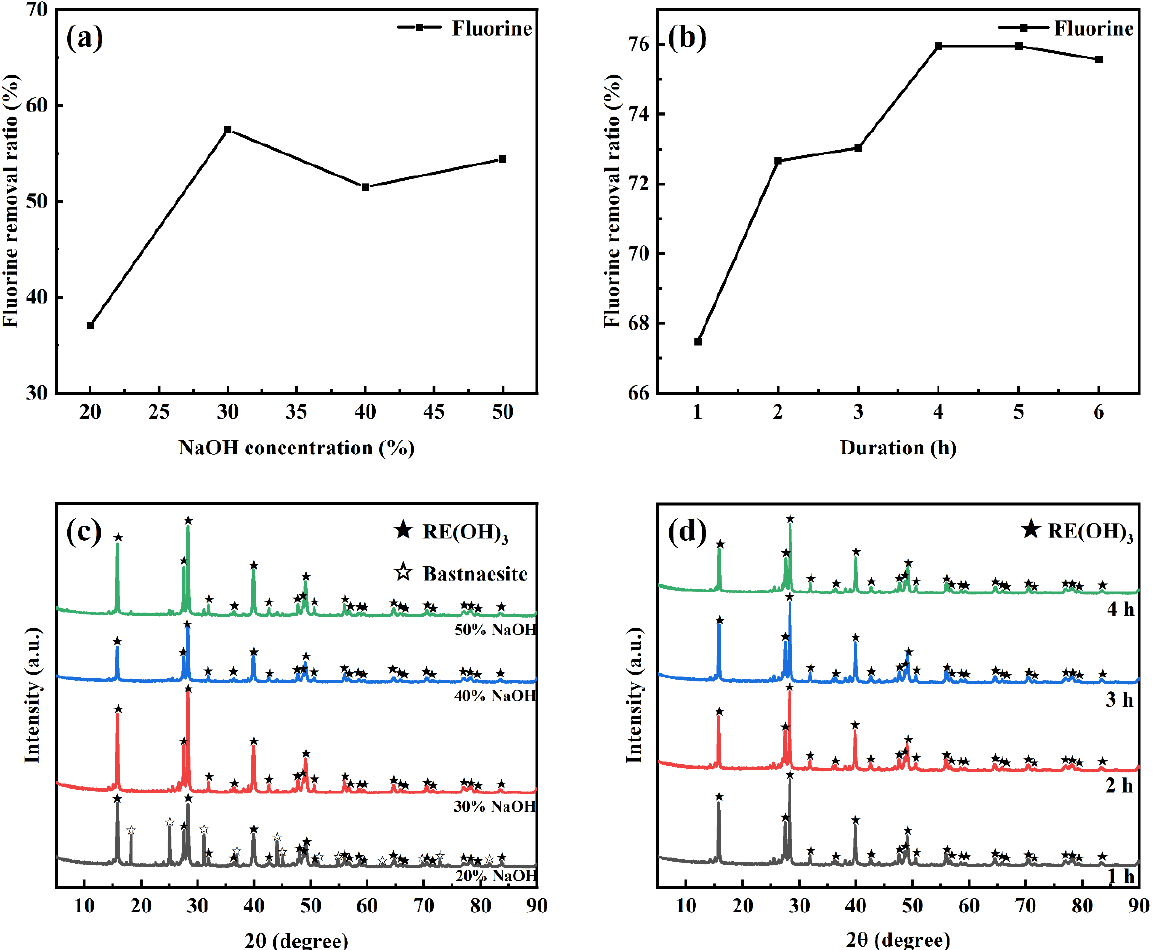
Figure 4. Effect of NaOH concentration ( a ) and reaction duration ( b ) on fluorine removal ratio (the NaOH concentration of reaction duration experiments is 30%), and XRD analysis results of products with different NaOH concentration ( c ) and reaction duration ( d ).